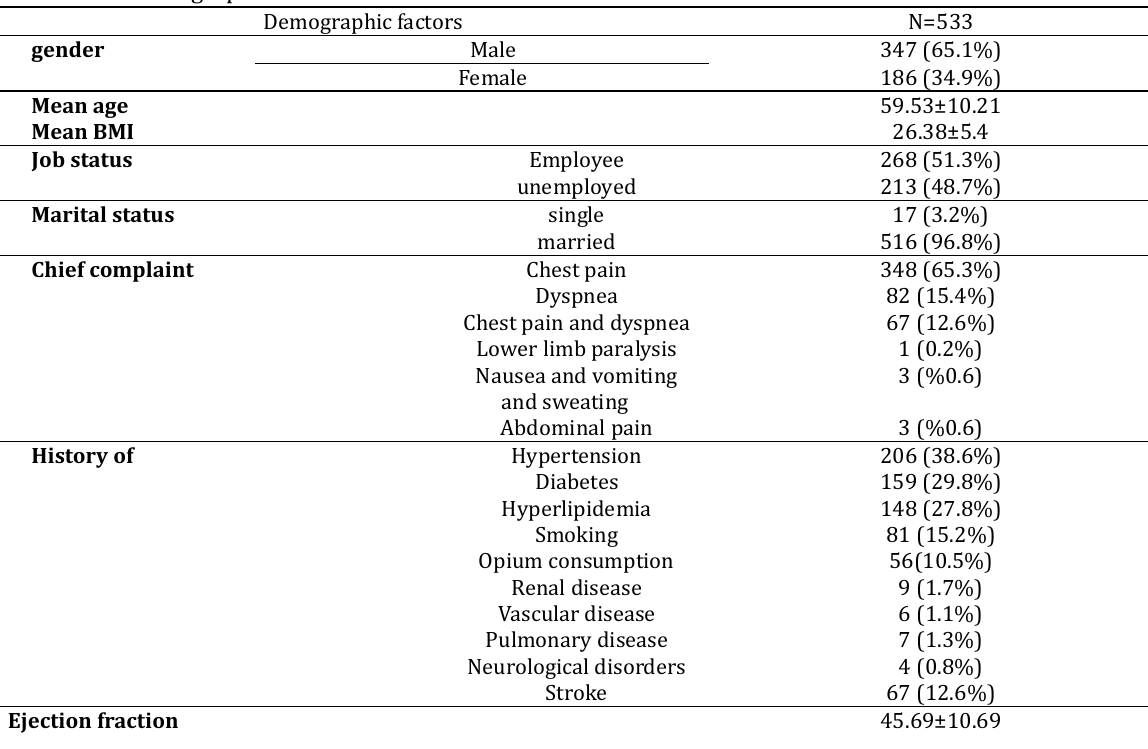
Table 1 : Demographic data